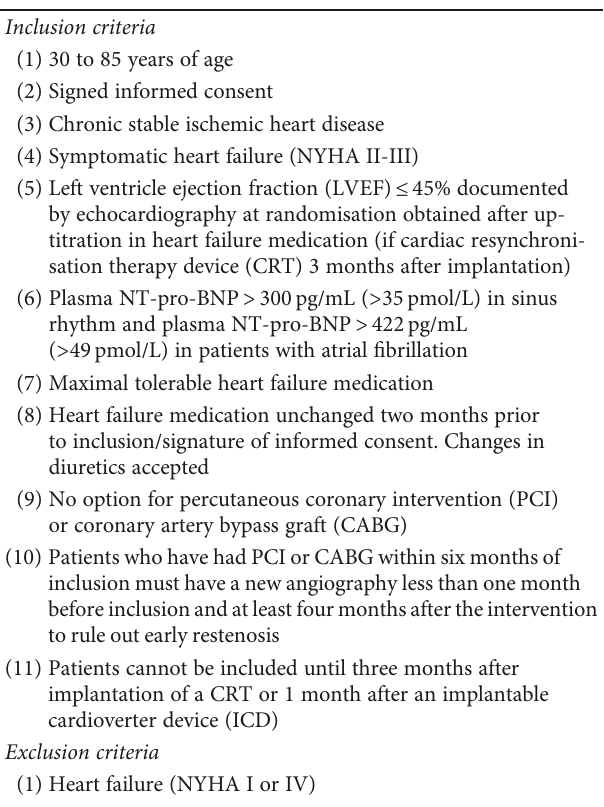
Table 1: Inclusion and exclusion